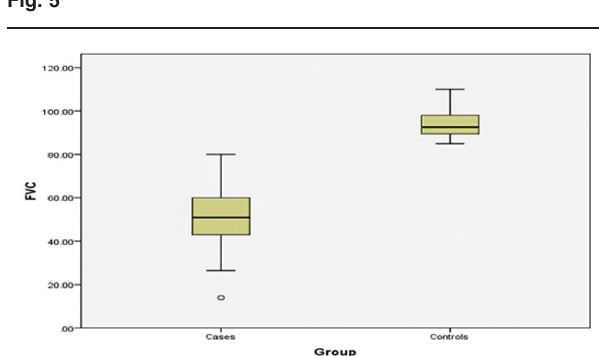
Comparison between cases and controls regarding forced vital ca- pacity.